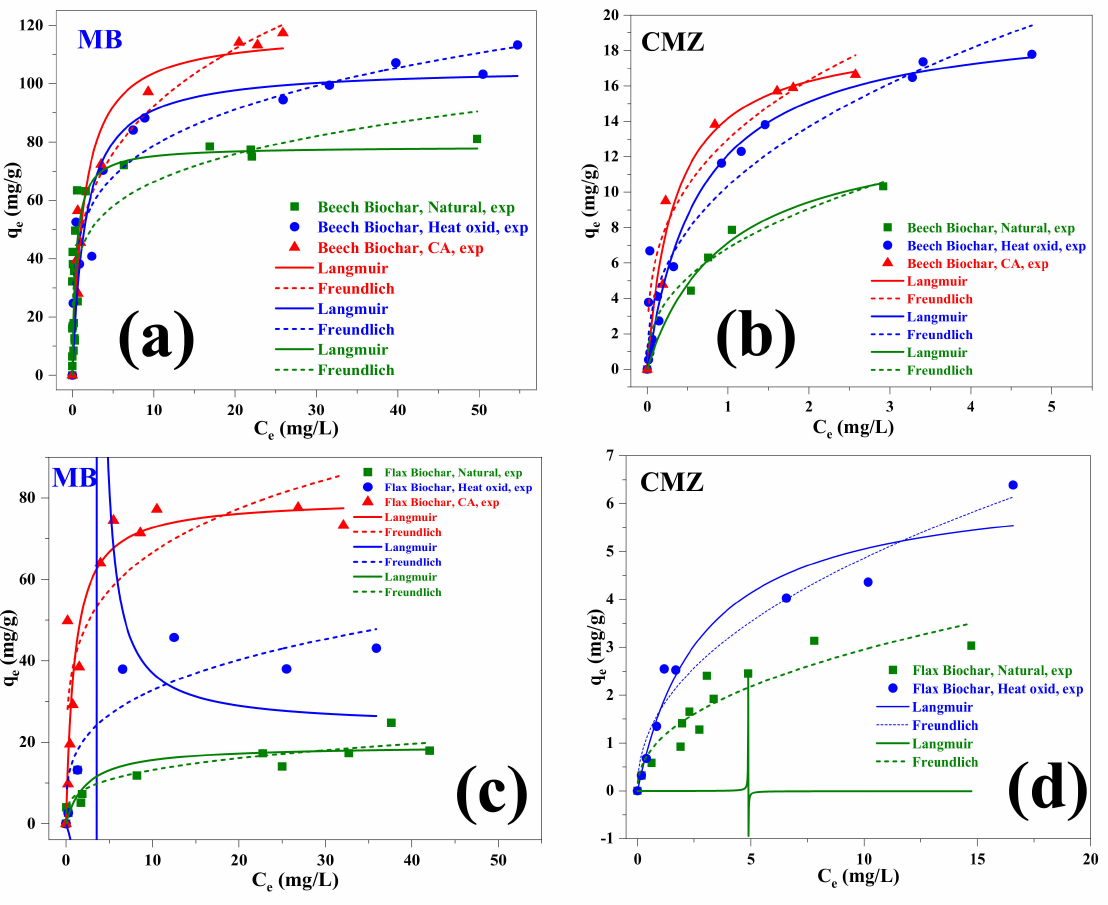
Figure 6. Equilibrium isotherms (smooth lines) and experimental data (points) for: MB adsorption on beech biochar ( a ) and flax biochar ( c ), CMZ adsorption on beech biochar ( b ) and flax biochar ( d